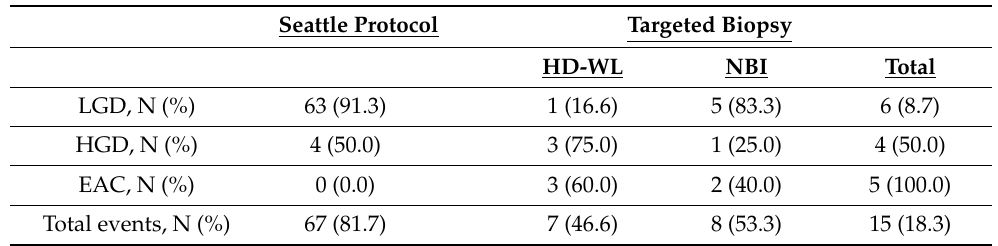
Table 2. Prevalence of dysplasia (N = 82) stratified by biopsy type and dysplasia grade. Seattle